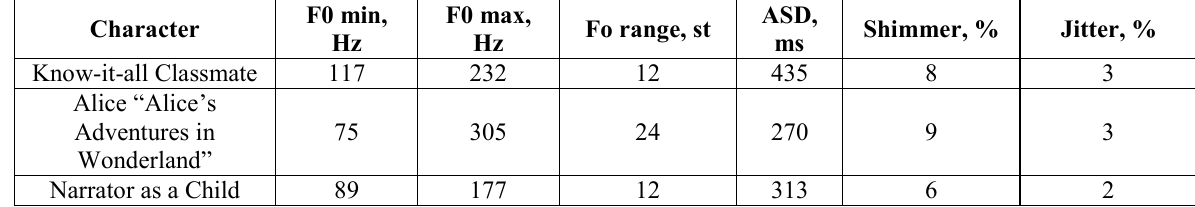
Table 3. rosodic characteristics of children’s voices (n=3)